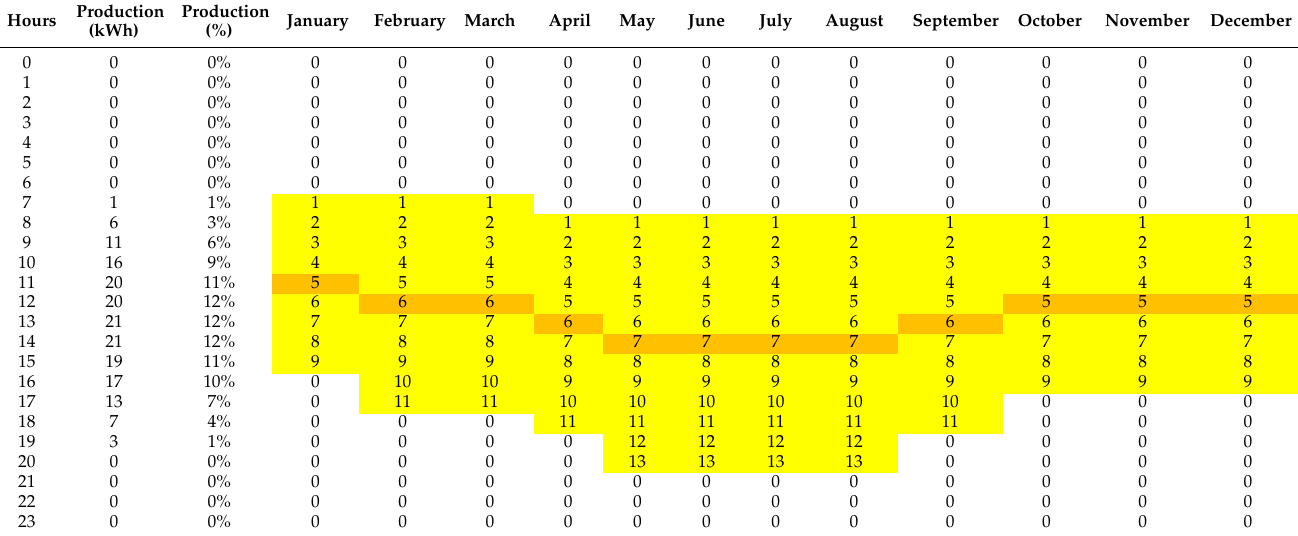
Table 3. Distribution of PV energy production and the respective hourly percentages.